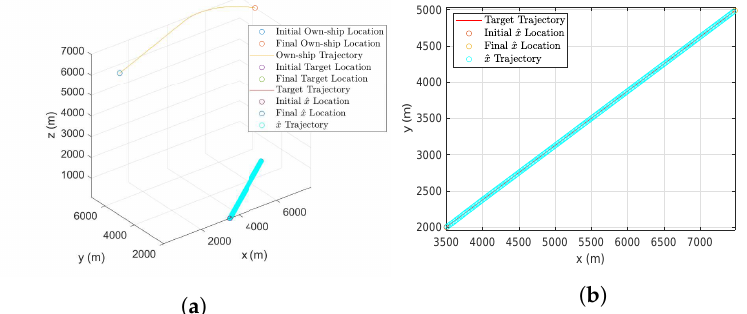
Figure 11. Tracking a mobile ground target with terrain uncertainty using a biased angle-only airborne sensor. ( a ) 3D CCS representation of the target-sensor geometry with the estimated trajectory. ( b ) 2D CCS representation of the target and the estimated